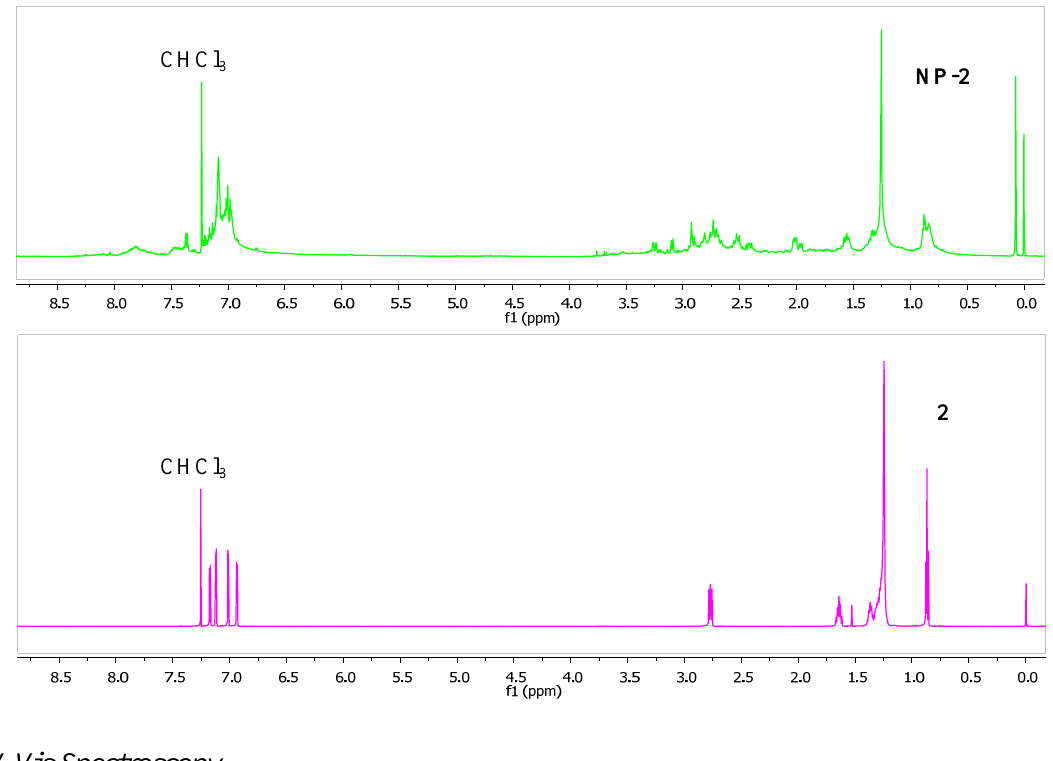
Figure 2. The 1 H-NMR-spectra of compound 2 and NP-2 measured in CDCl